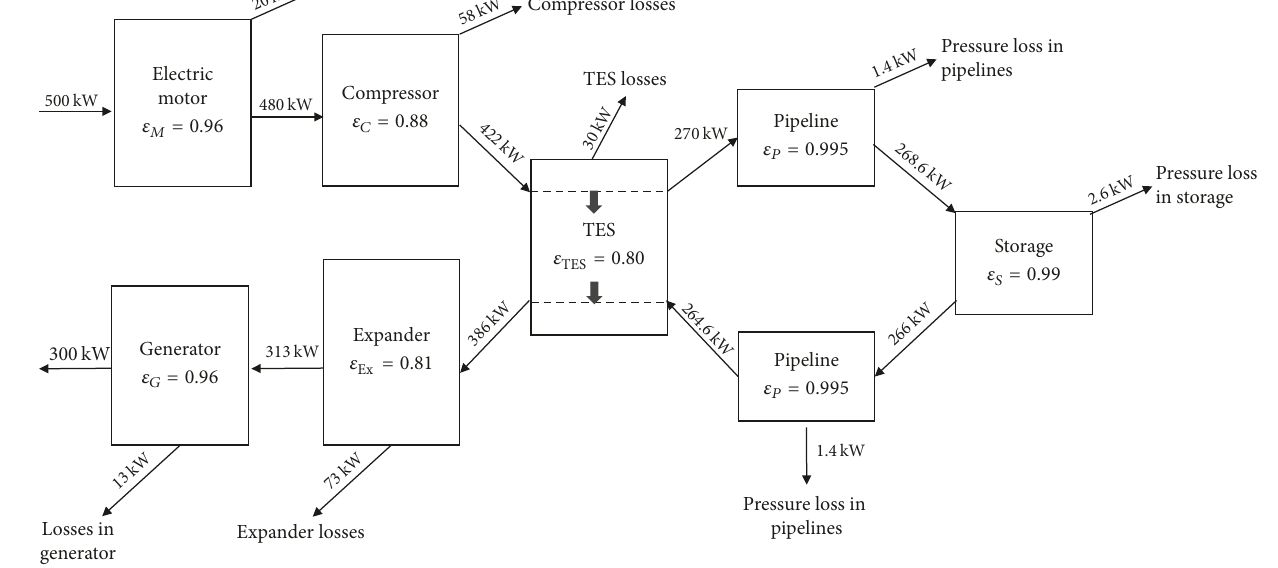
Figure 6: Exergy flow in adiabatic OCAES.